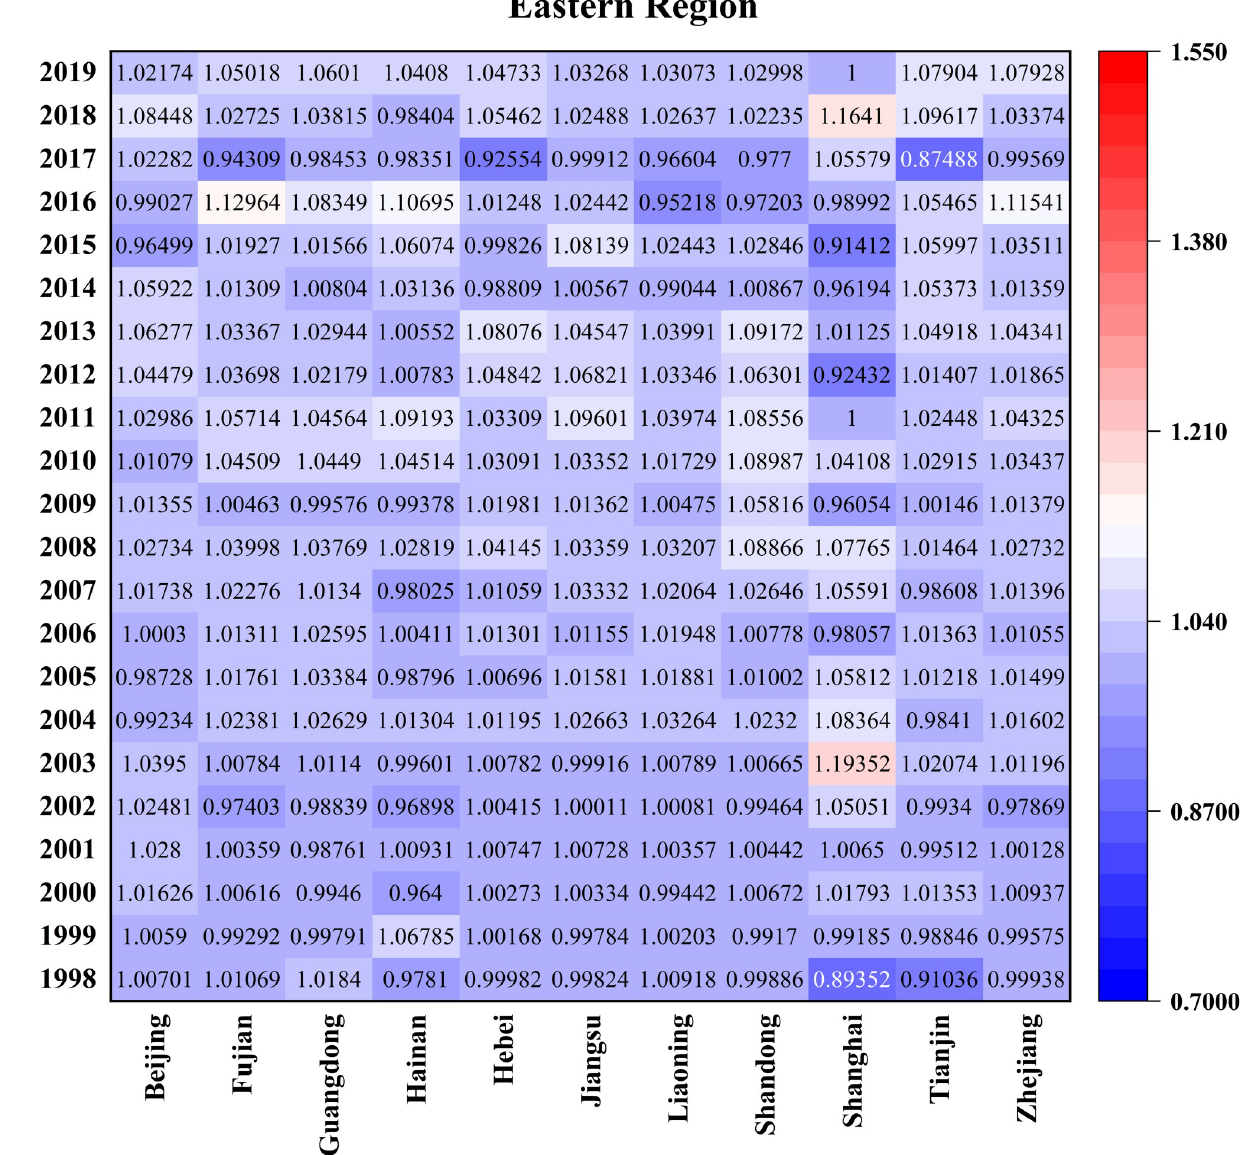
Fig 7. Time variation and average TGRs of GATFP in the eastern